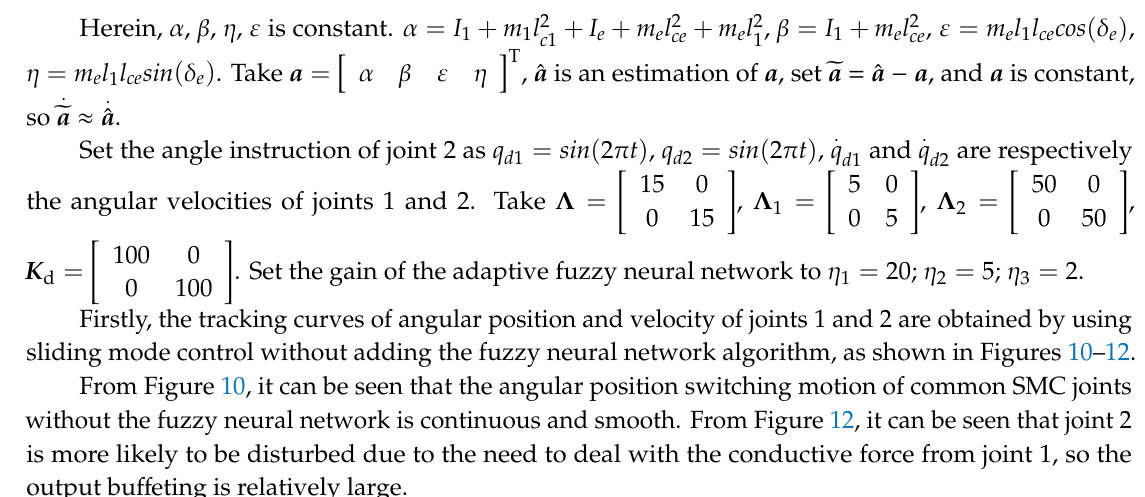
Figure 11. Angular velocity tracking of joints 1 and 2. Figure 12. Joint 1 and 2 control inputs without neural network sliding mode.